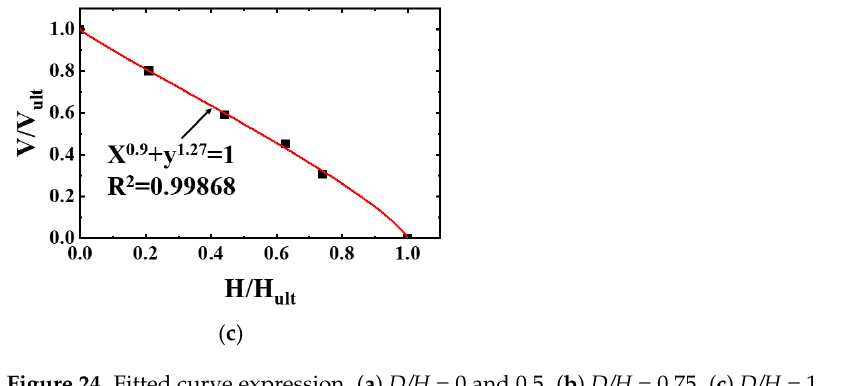
Figure 24. Fitted curve expression. ( a ) D/H = 0 and 0.5. ( b ) D/H = 0.75. ( c ) D/H = 1.